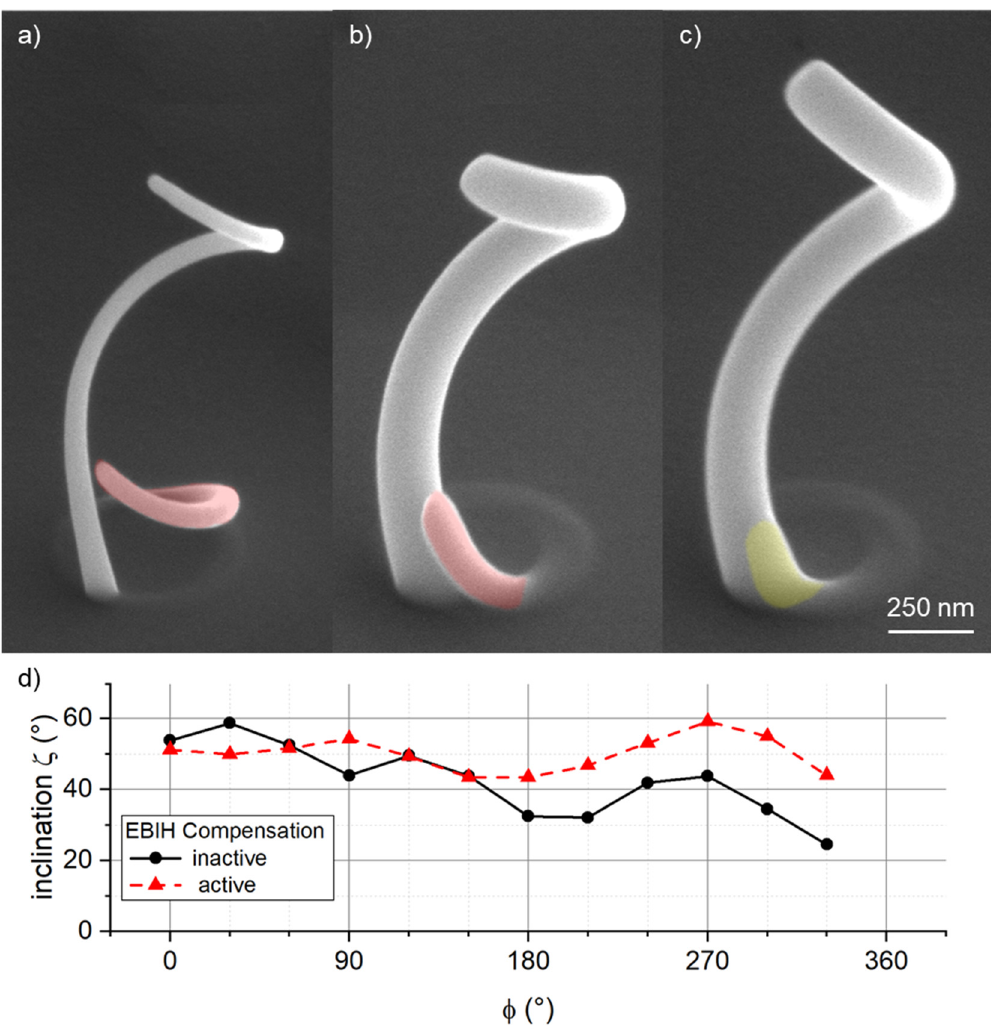
Figure 6. The impact of beam blurs on 3D helices. In contrast to in-focus conditions ( a ), 0 nm blur, 7 ms DT, a blurred electron beam widens the segments cross-section as intended and delays the occurrence of co-deposition (shaded red) ( b ), 266 nm blur, 50 ms DT. The azimuthally resolved inclination angle of the latter is shown in ( d ) by black circles, which reveal a general decay, which is also qualitatively evident in the SEM image in ( b ) (compressed upper part). That effect can be related to electron beam induced heating (see text) and can be compensated, as evident by the red triangles in ( d ). The corresponding SEM image in ( c ) clearly confirms the improved quality of the helix and furthermore reveals no lift-off co-deposit underneath (shaded yellow, compare to ( b ). Please note the always evident, thin ring underneath the segments, which suggests transmitting electrons in agreement with the literature.